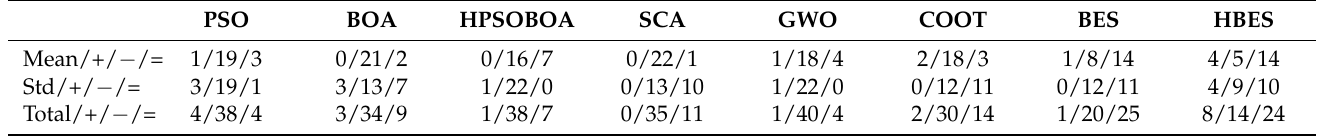
Table 3. Comparison results of benchmark